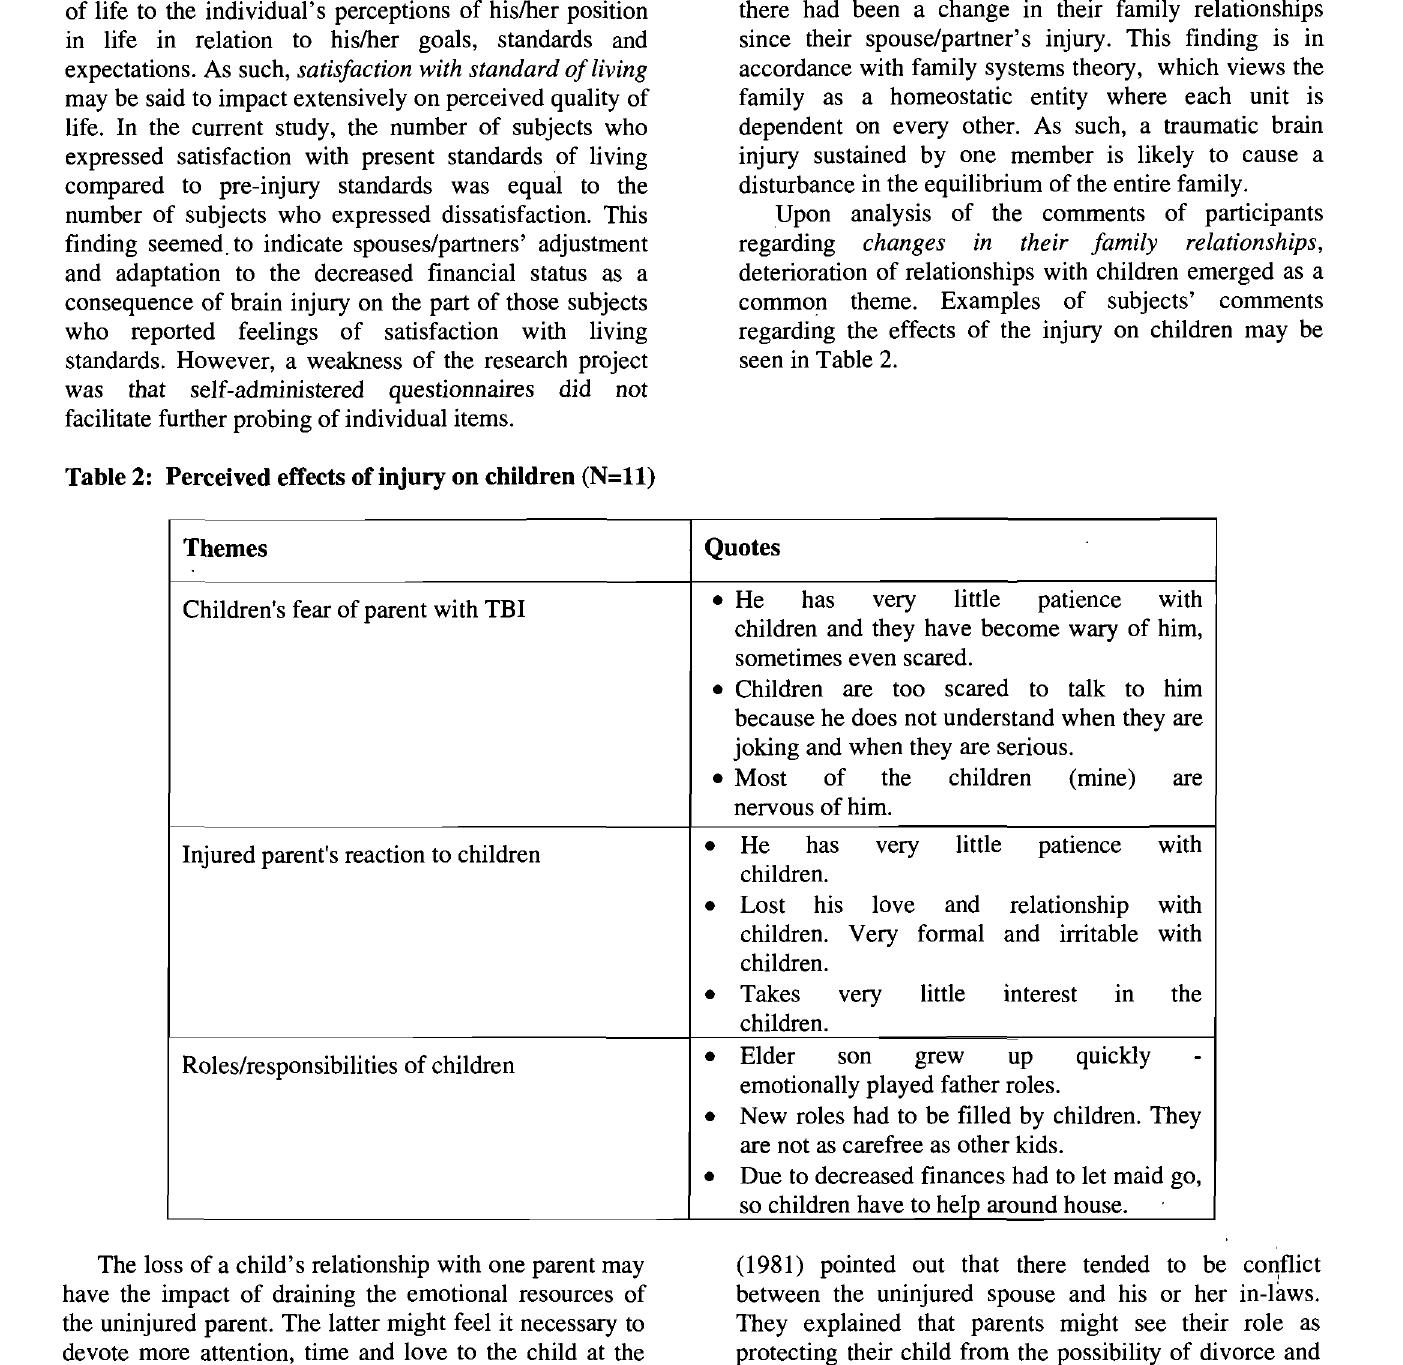
Table 2: Perceived effects of injury on children